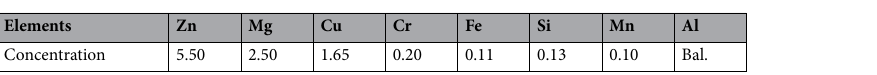
Elements Zn Mg Cu Cr Concentration Table 1. Chemical composition of AA7075